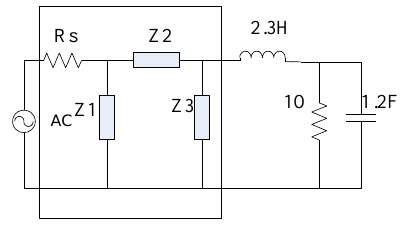
Figure 4. Initial EIMN topology of GA.